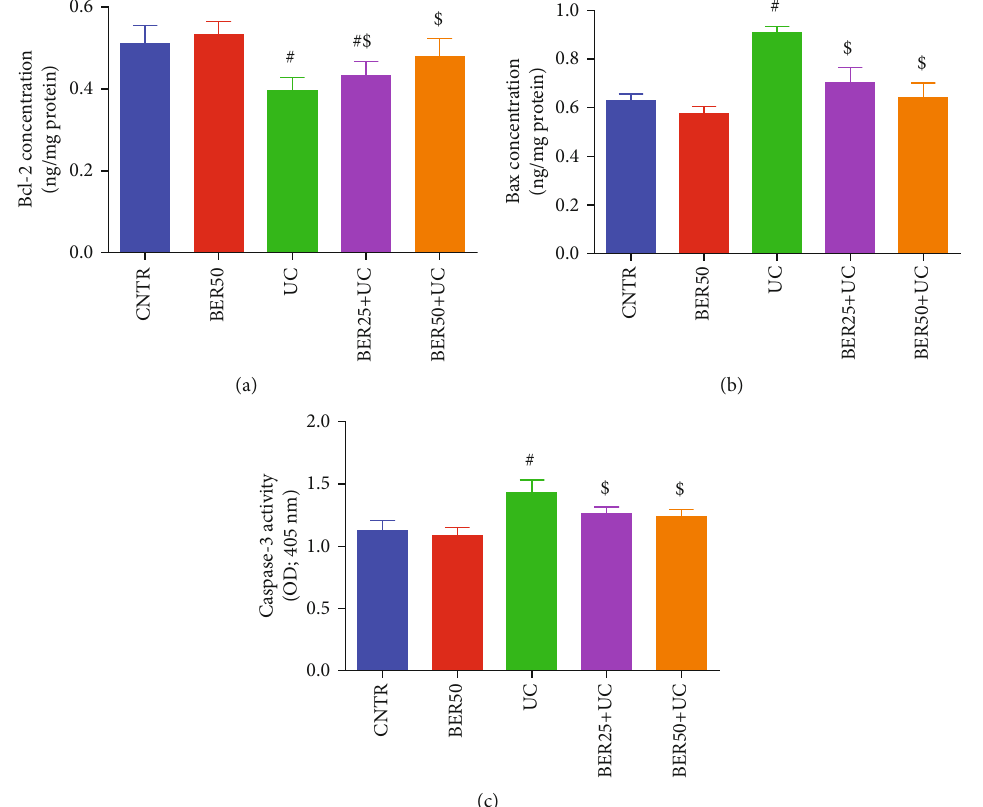
Figure 9: E ff ect of berberine at di ff erent doses on apoptosis-related protein ((a) Bcl-2, (b) Bax, and (c) caspase-3) in colonic tissue of experimental colitis in rats. The results are expressed as the mean ± SD ( n = 7 ). # p < 0 : 05 compared to the CNTR group (intact group); $ p < 0 : 05 compared to UC-untreated